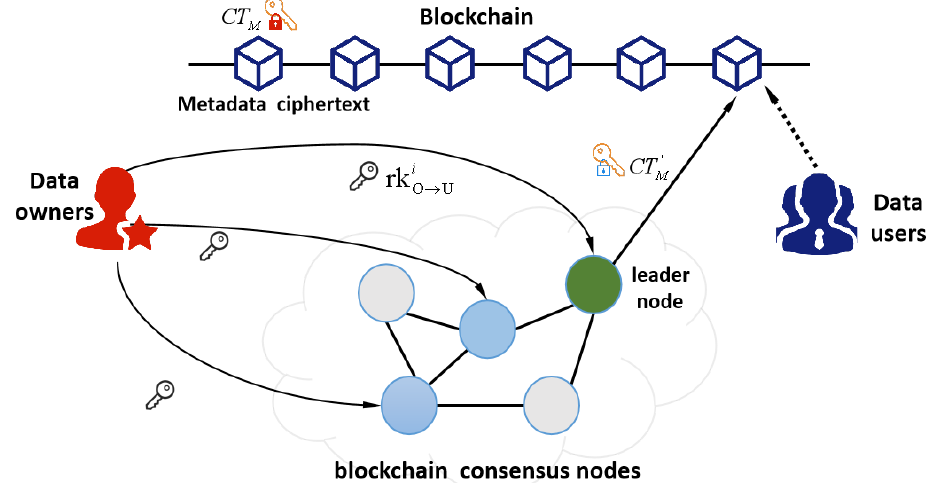
Figure 4. The consensus mechanism based on threshold proxy